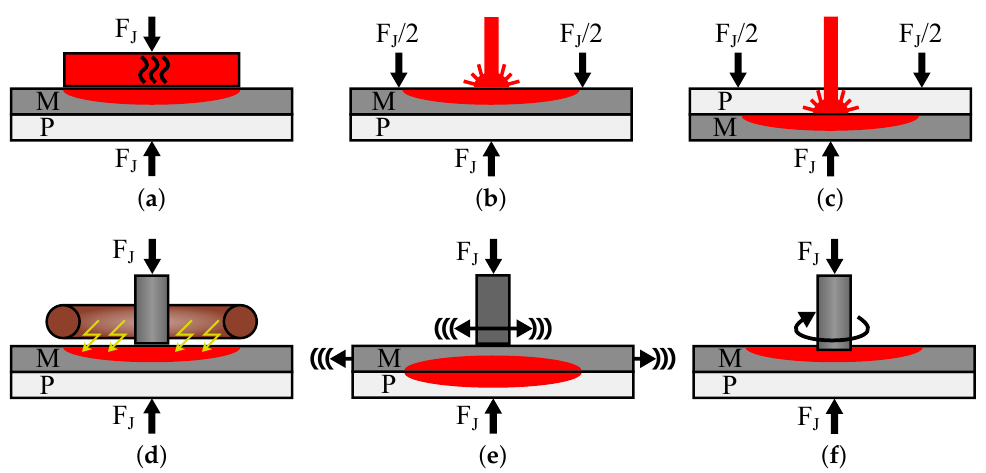
Figure 1. Schematic illustration of different thermal joining processes (P = polymer, M = metal): ( a ) heat conduction joining, ( b ) laser-heat conduction joining, ( c ) laser direct joining, ( d ) induction joining, ( e ) ultrasonic welding, ( f ) friction